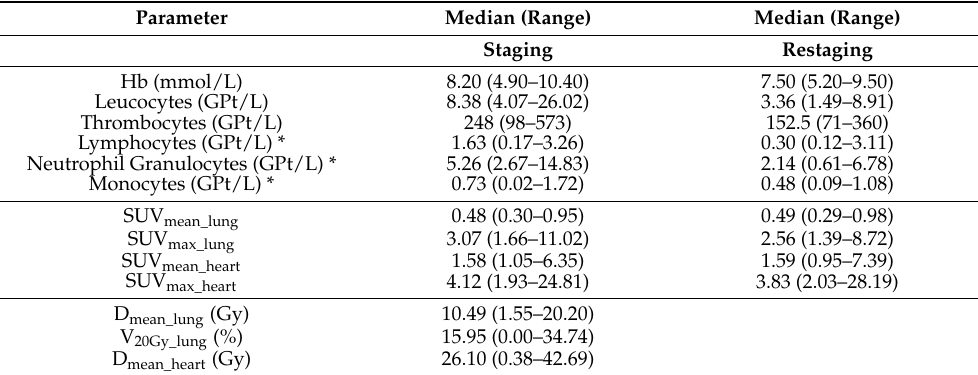
Table 2. Overview of the investigated parameters. As an exception, blood counts of lymphocytes, neutrophil granulocytes and monocytes (marked with an asterisk *) were only available in 45 patients at staging and in 26 cases at